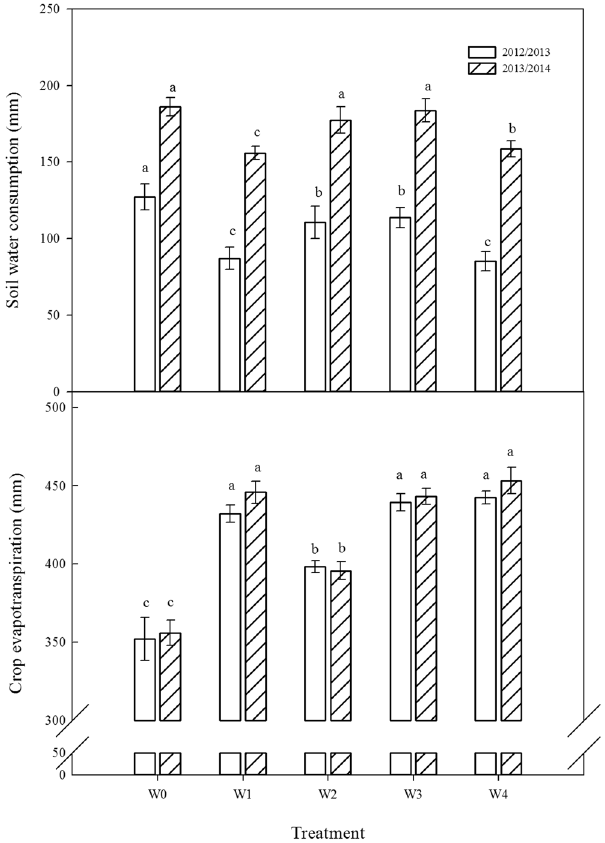
Figure 2. Responses of soil water consumption and crop evapotranspiration from 0–200 cm soil profile to different treatments in 2012/2013 and 2013/2014 growing seasons: rainfed (W0), a local supplemental irrigation practice with 60 mm of irrigation each at jointing and anthesis (W1), supplemental irrigation determined by measuring 0–20 cm (W2), 0–40 cm (W3), and 0–60 cm (W4) soil layers moisture and brought the soil moisture to 65% field capacity (FC) at jointing and 70% FC at anthesis. In the same growing season, the different letters in the figure are significant at the 0.05 level. Vertical bars are standard error of the mean (n = 3).